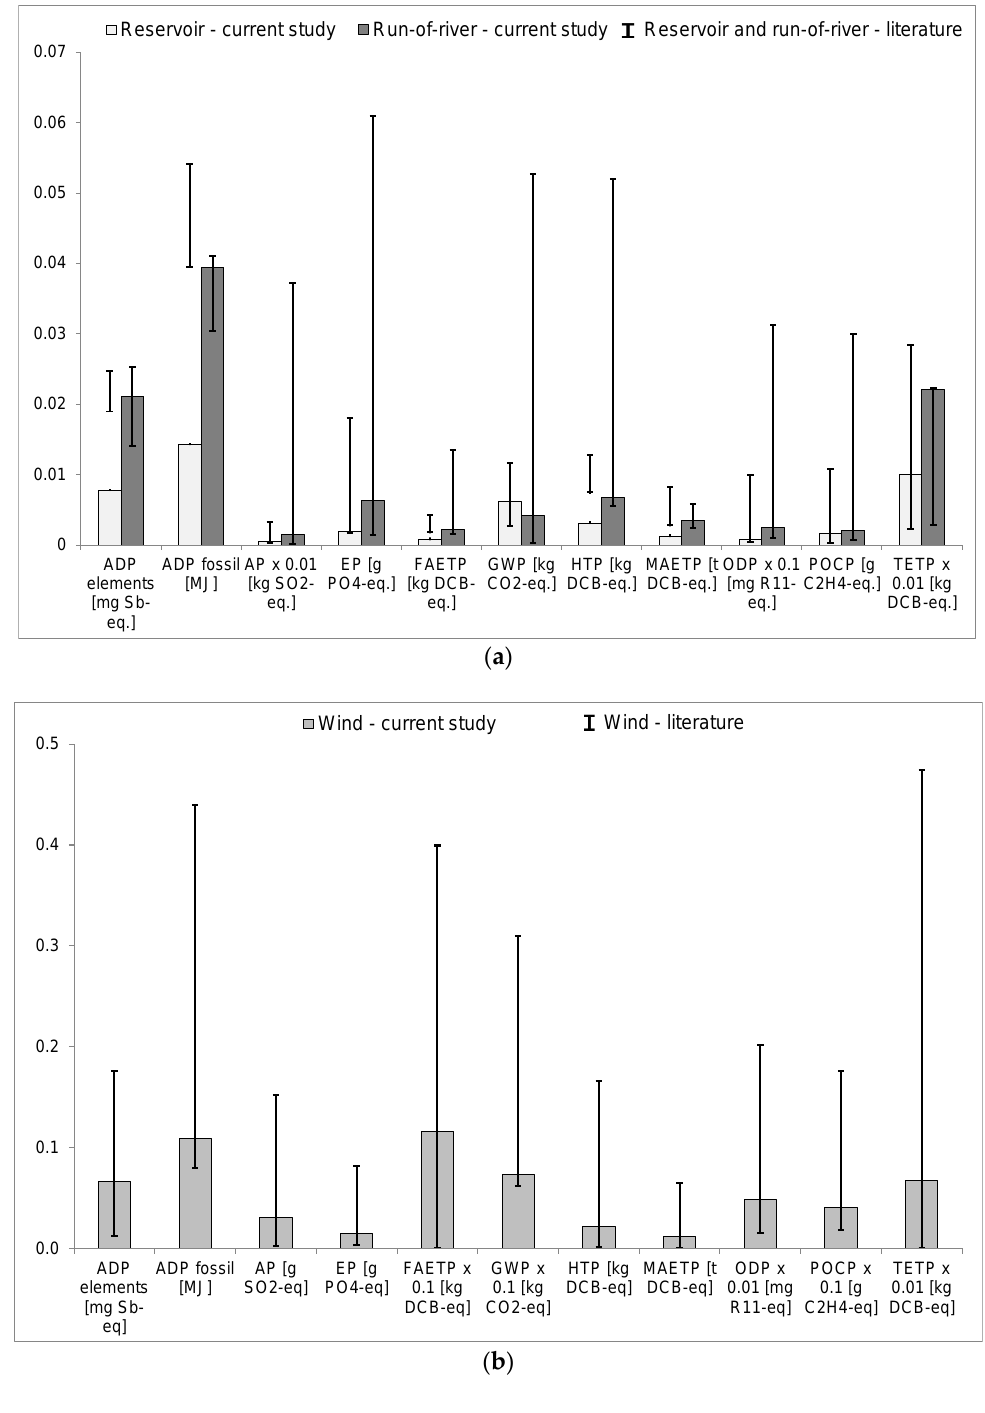
Figure 5. Comparison of the results from current study with literature for hydropower and wind power. ( a ) Reservoir and run-of-river hydropower. ( b ) Onshore wind. [All impacts expressed per kWh of electricity generated. The current study results for the reservoir hydropower present the average value for large and small reservoir. Literature data for reservoir from: [30], [43], [44]; for run-of-river from: [20], [23], [26], [29], [43], [44], [45]; for onshore wind from [22], [25], [28], [31], [33] and [43]. All impacts estimated using the CML 2001 method. For impacts nomenclature, see Figure 3.].